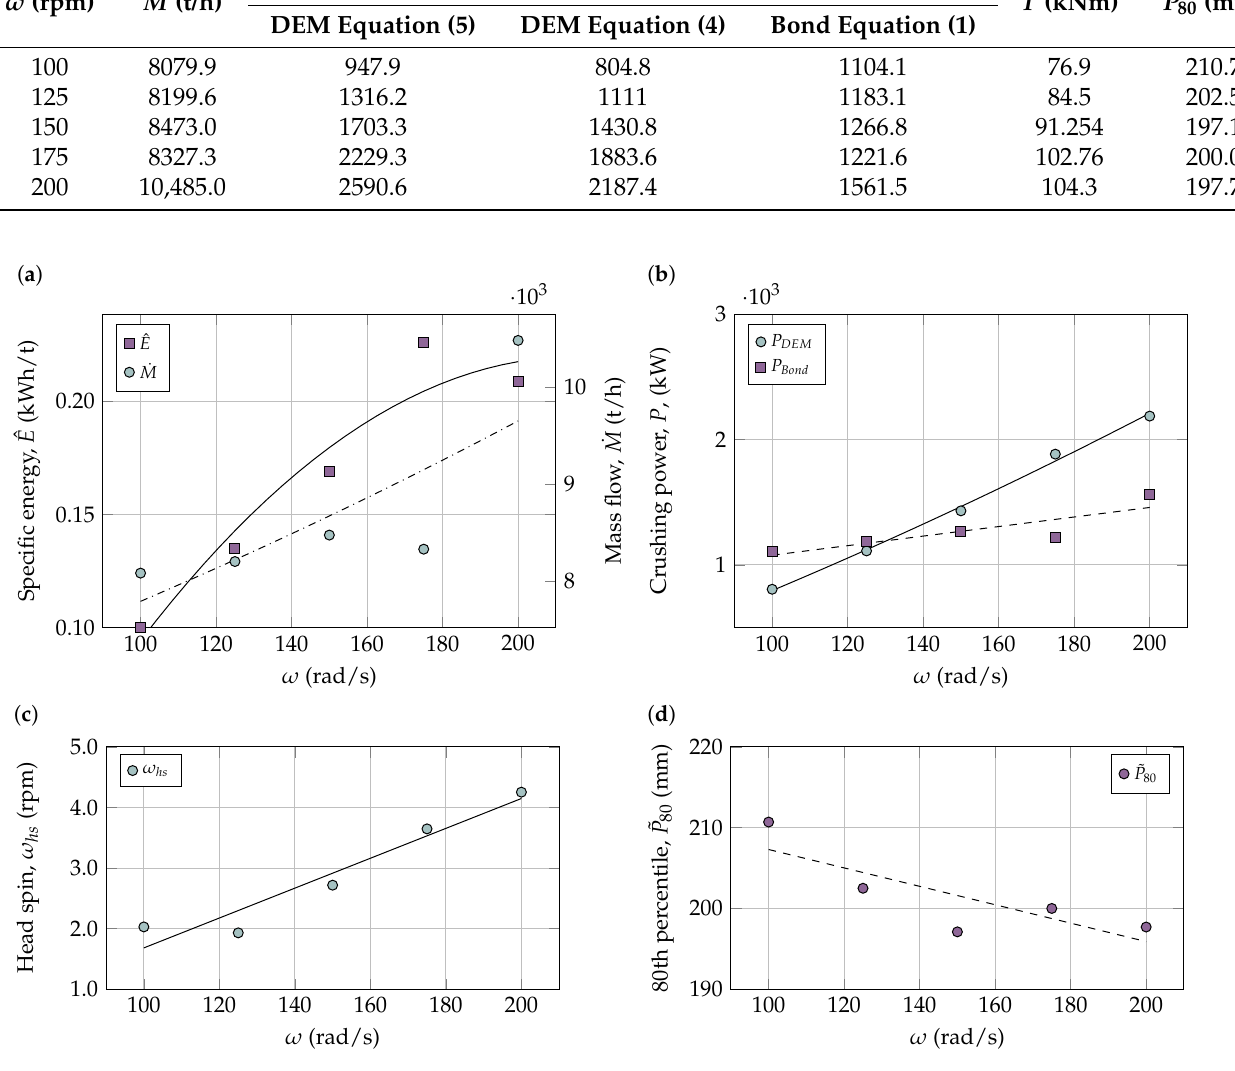
Figure 12. Results of simulations changing the eccentric angular speed: ( a )mass flow rate and specific energy, ( b )power comparison with Bond, ( c )head spin, and ( d )80th percentile of the product size